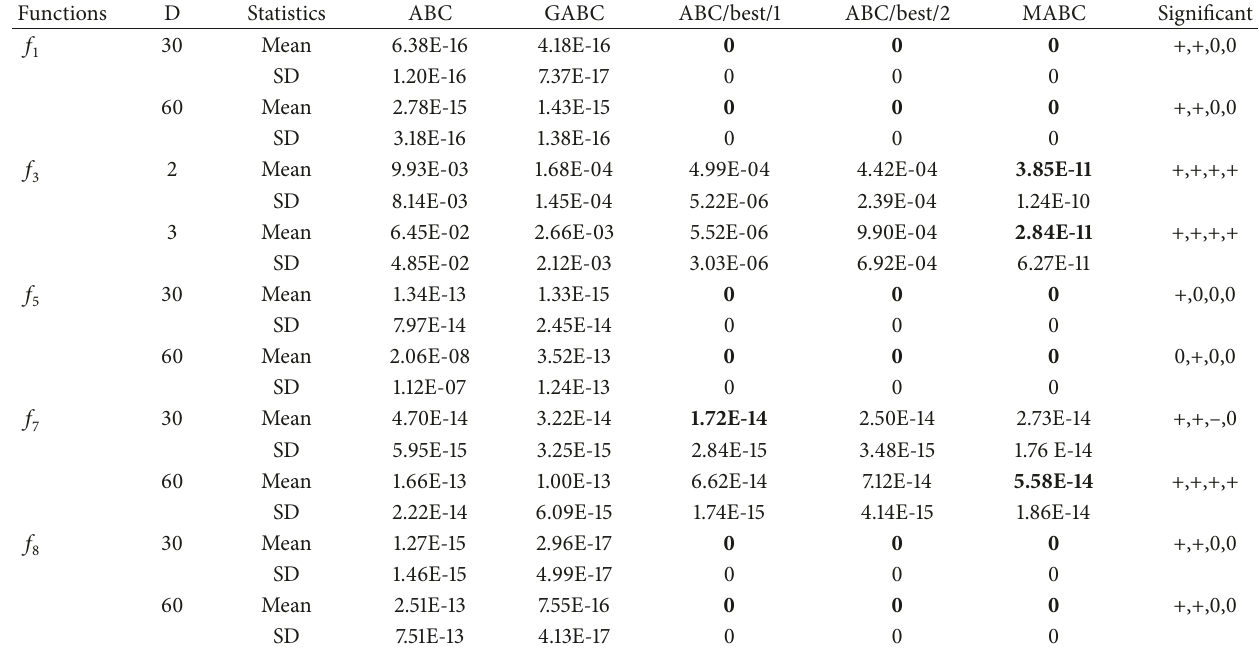
Table 2: Performance comparison of ABC, GABC, ABC/best/1, ABC/best/2, and MABC